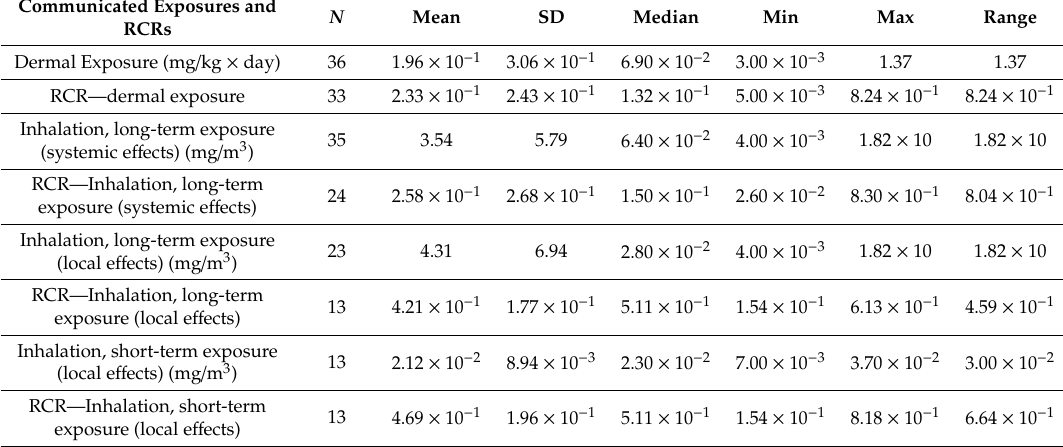
Table 5. Number of valid ( N ) communicated exposure estimates and associated risk characterization ratios (RCRs) for each route of exposure. SD: standard deviation; Min: minimum; Max: maximum.